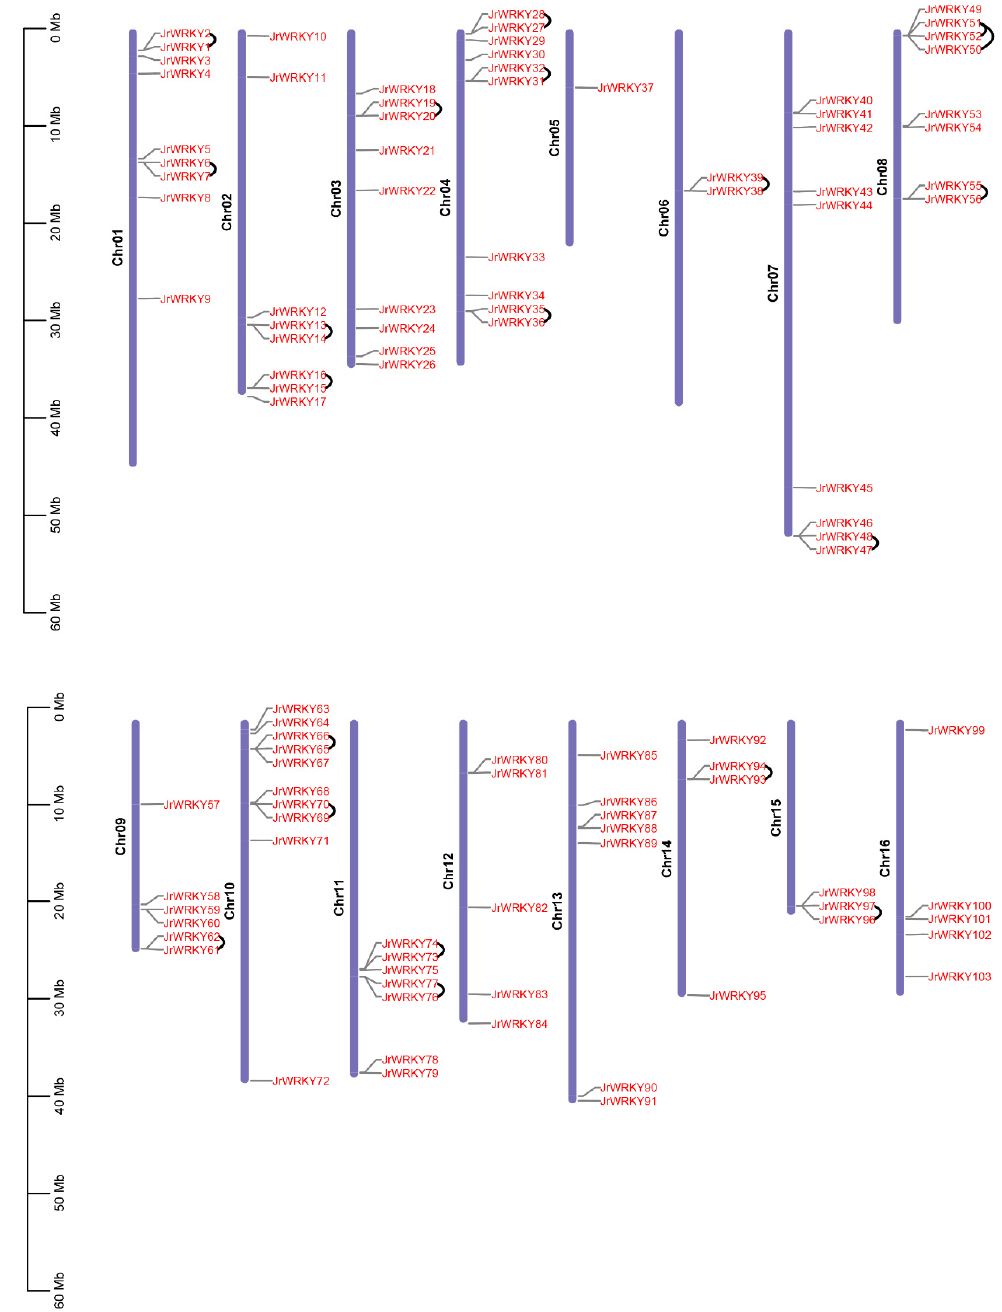
Figure 3. Chromosome location and tandem analysis of WRKY genes. The blue boxes represent chromosomes of walnut; black lines represent the tandem relationships of WRKY genes in walnut.